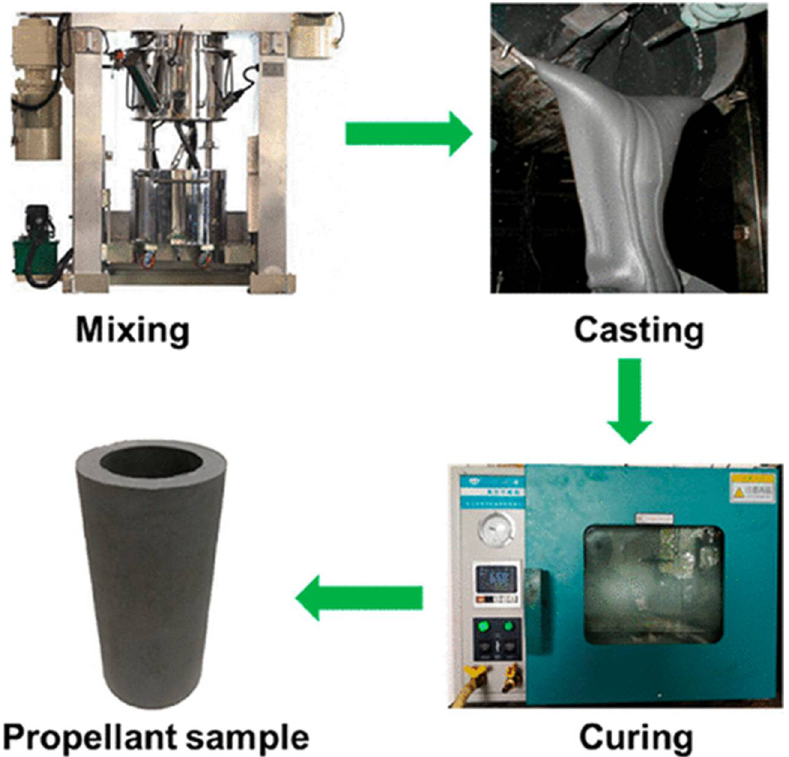
Figure 2. Manufacturing process of HTPB propellant. Reprinted (adapted) with permission from [17]. Copyright 2021, American Chemical Society.